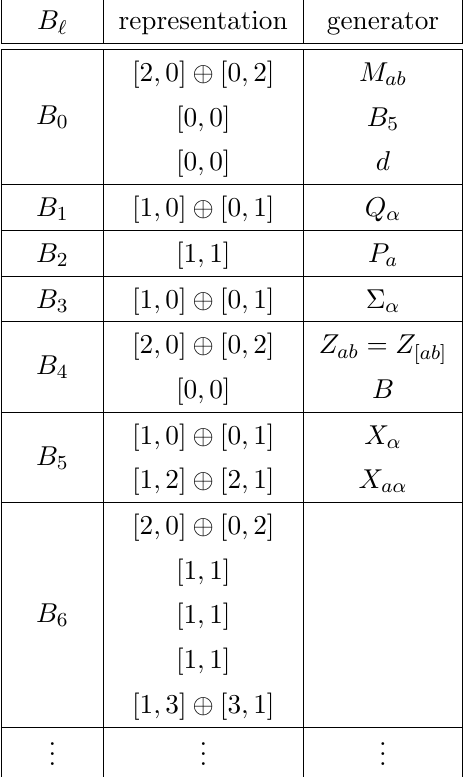
Table 6 . The non-negative levels of the Borcherds superalgebra de(cid:12)ned by the Cartan matrix (4.3). This is a quotient of the free Lie superalgebra shown in table 2 and the notation is in that table. We have also included the Cartan generators from level ‘ = 0. B 5 acts as chirality while d is a scaling operator. Up to level ‘ = 4 this is the Maxwell superalgebra studied in